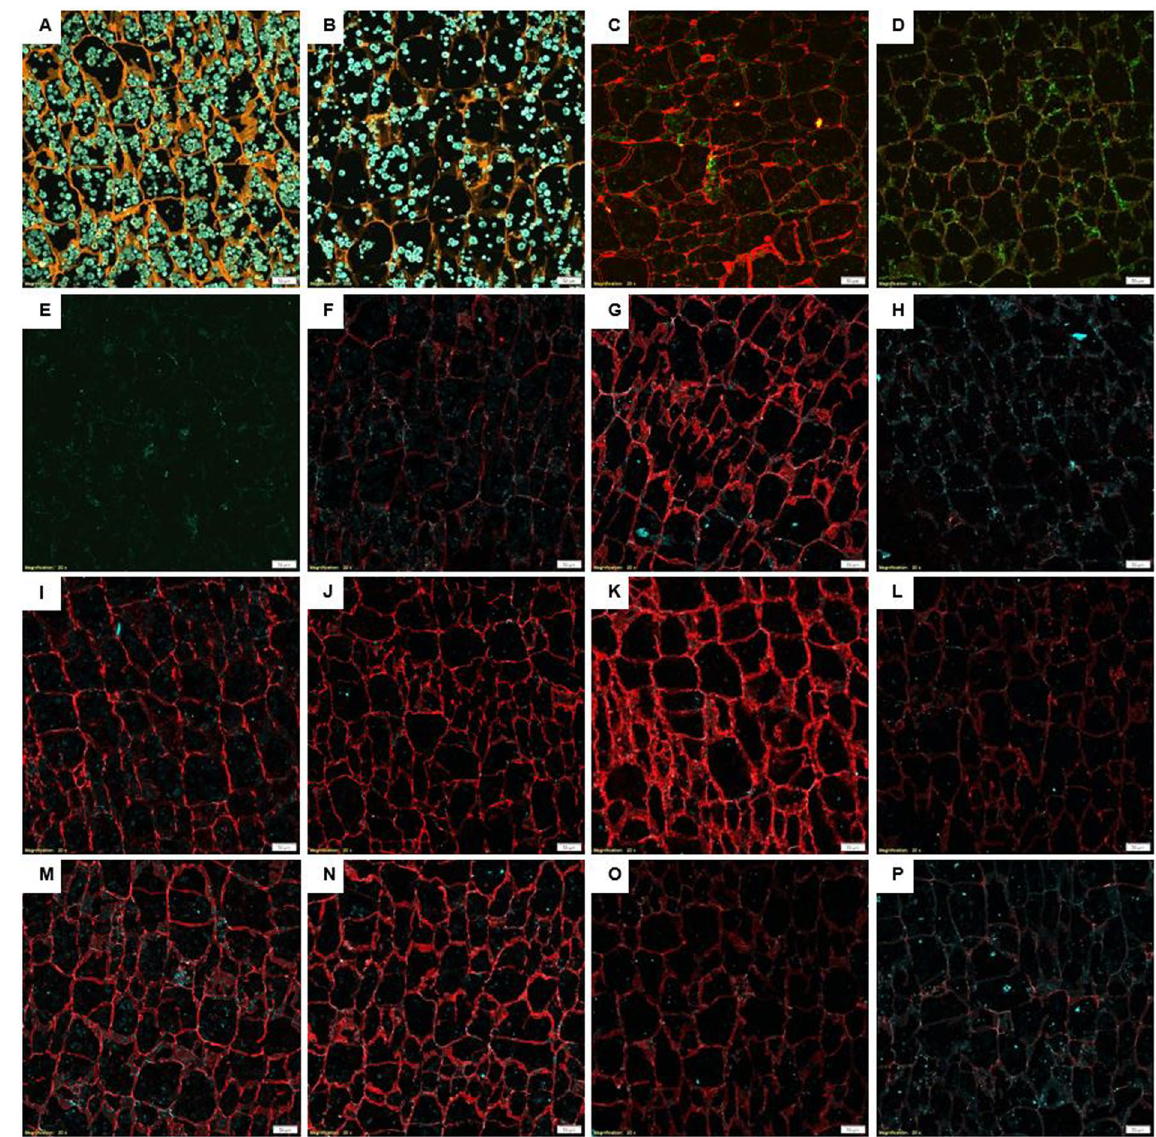
Figure 2. Confocal microscopy pictures of cassava sections. Cassava sections studied under a 20x objective (scale bar = 50 µ m). Orange indicates Coriphosphine-O fluorescence. Red indicates Alexa-555 fluorescence. Blue/green indicates auto-fluorescence. ( A) Control treatment dyed with Coriphosphine-O. ( B) Treatment with NSPase at 250 ppm and dyed with Coriphosphine-O. ( C) Control labelled with INRA-RU1. ( D) Treatment with NSPase at 250 ppm and labelled with INRA-RU1. ( E) Blank, sample labelled only with the secondary antibody attached to Alexa-555. ( F) Control labelled with LM19. ( G) Treatment with NSPase at 250 ppm and labelled with LM19. ( H) Treatment with NSPase at 800 ppm and labelled with LM19. ( I) Control treatment labelled with LM25. ( J) Treatment with NSPase at 250 ppm and labelled with LM25. ( K) Treatment with NSPase at 400 ppm and labelled with LM25. ( L) Treatment with NSPase at 800 ppm and labelled with LM25. ( M) Control treatment labelled with LM5. ( N) Treatment with NSPase at 250 ppm and labelled with LM5. ( O) Treatment with NSPase at 400 ppm labelled with LM5. ( P) β -galactanase 10 ppm treatment labelled with